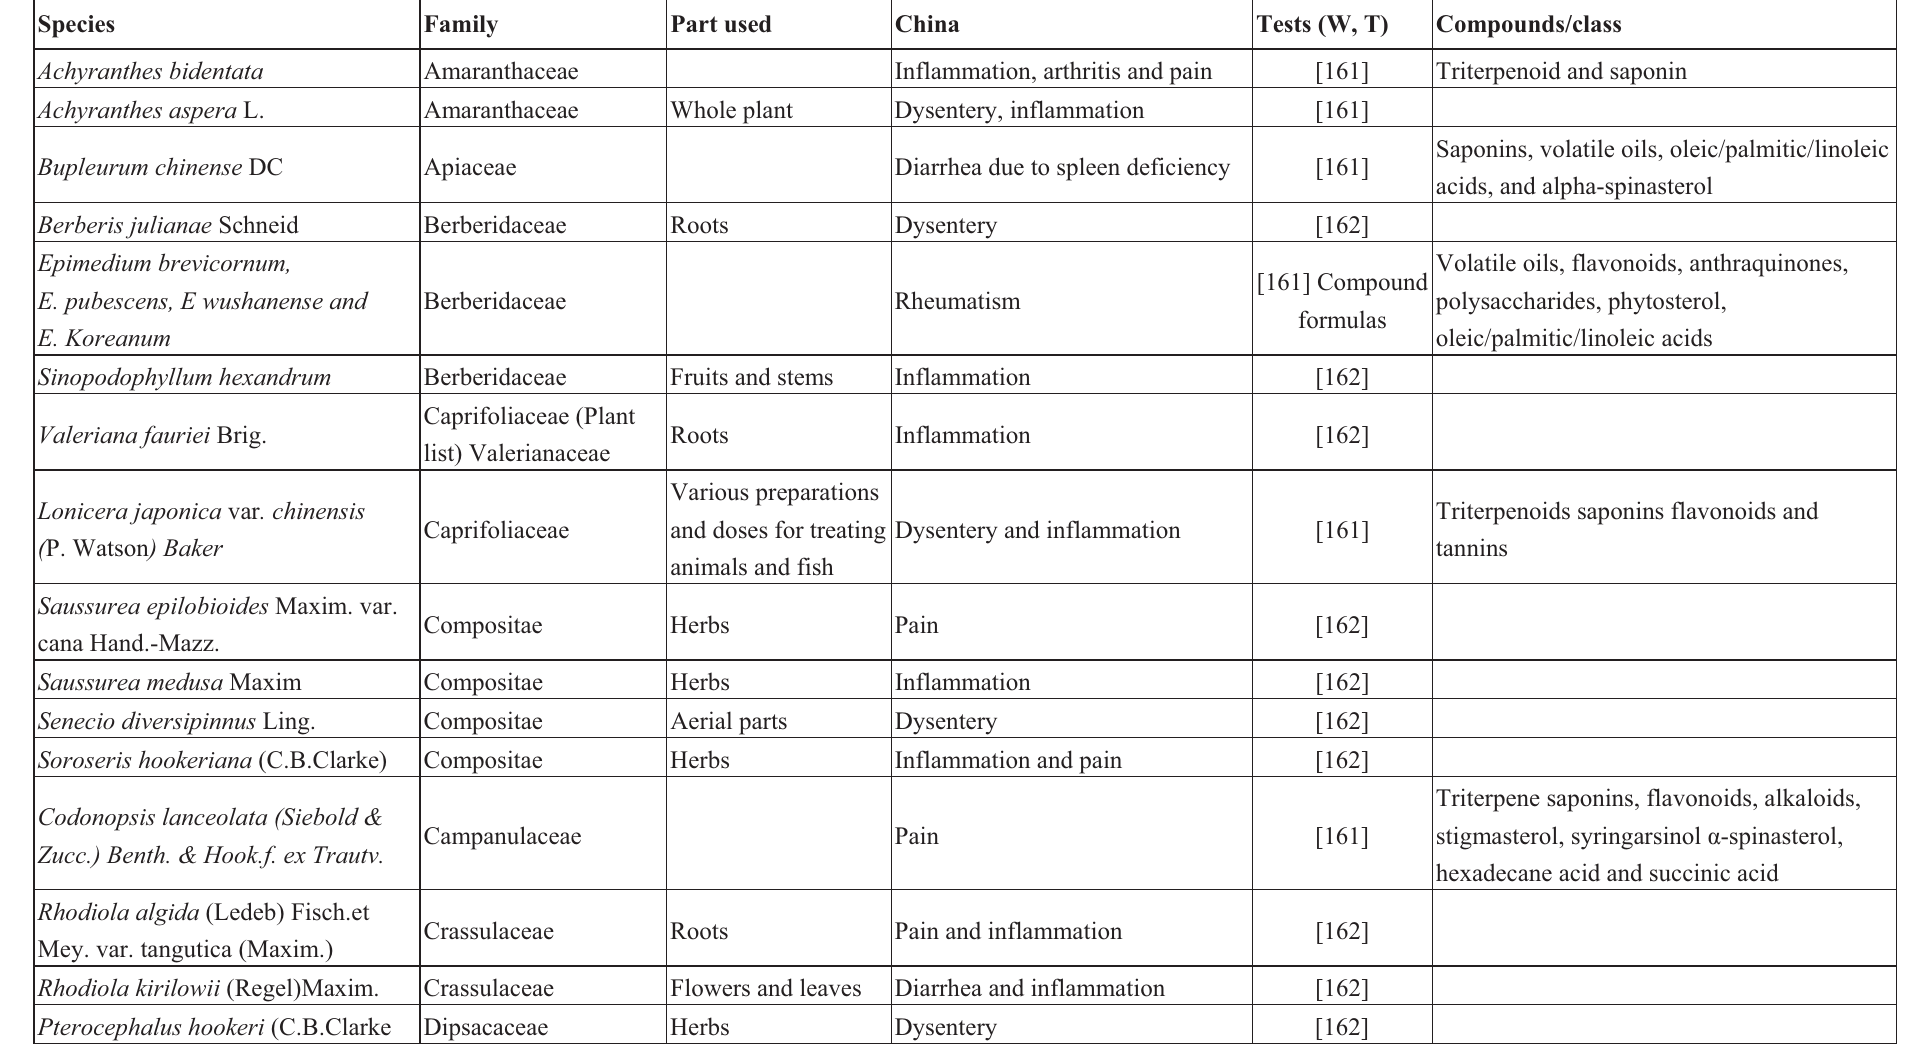
Table 4. An inventory of Chinese herbal preparations used to treat animal gastrointestinal pain and